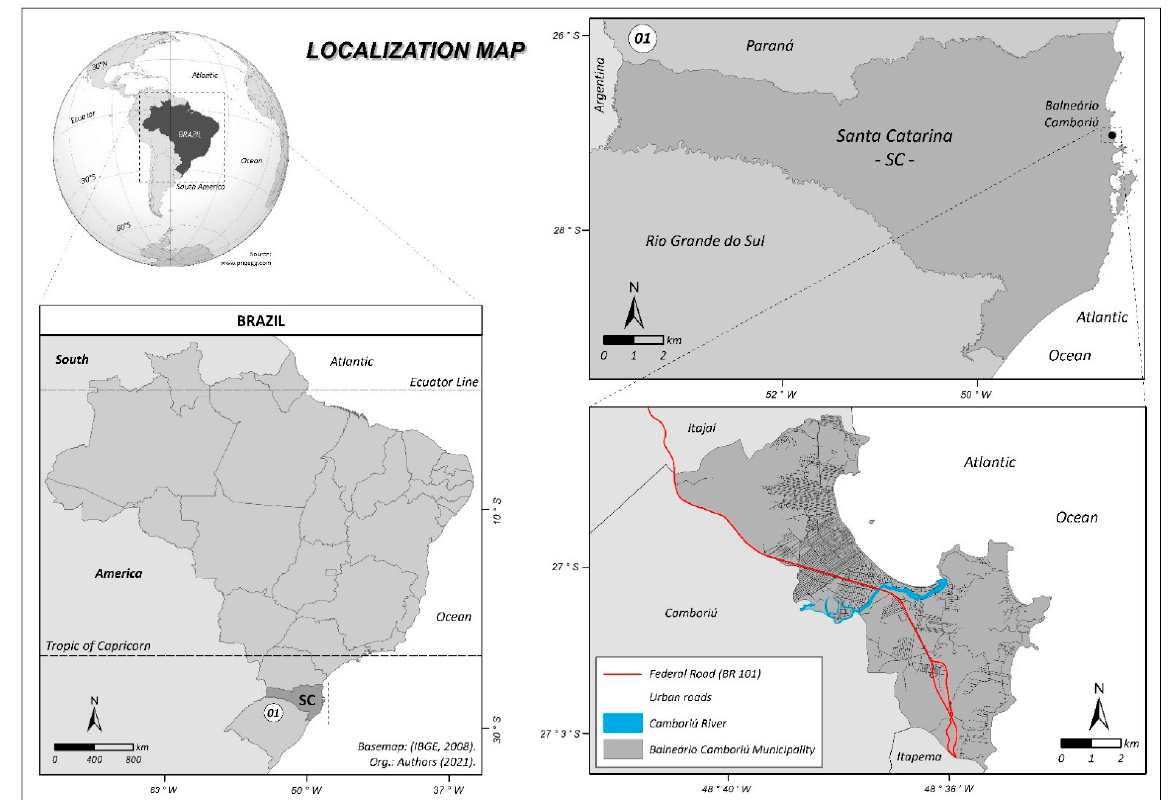
Figure 1. Location of the municipality of Balneário Camboriú. Source: [14]. The population forecast for 2021 is 149,227 according to the Brazilian Institute of Ge- ography and Statistics [15,16]. The entire population resides in the Balneário Camboriú urban area, the area of which is 46.80 km 2 with a population density of 2337.67 individuals per square kilometer and a human development index (HDI) of 0.845 [15,16].